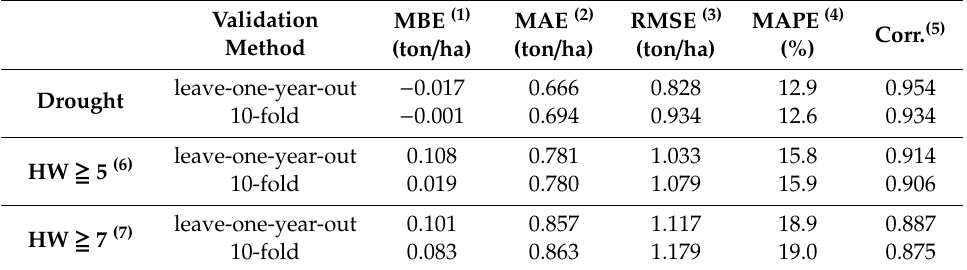
Figure 11. Concept of 10-fold cross-validation with random sampling for the blind tests of corn yield prediction during 2006 – 2015.